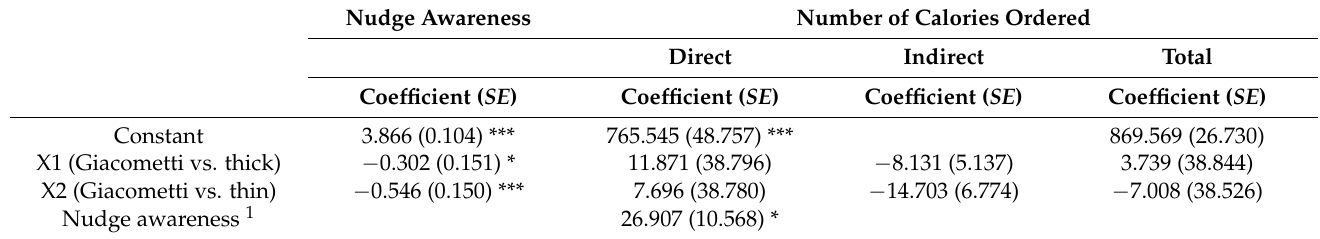
Table 4. Main results of the mediation